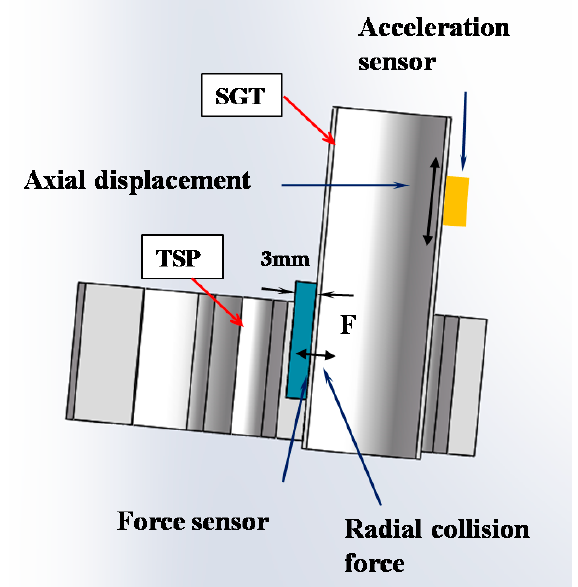
Figure 1. The sectional view of the steam generator tube (SGT) and the tube support plate